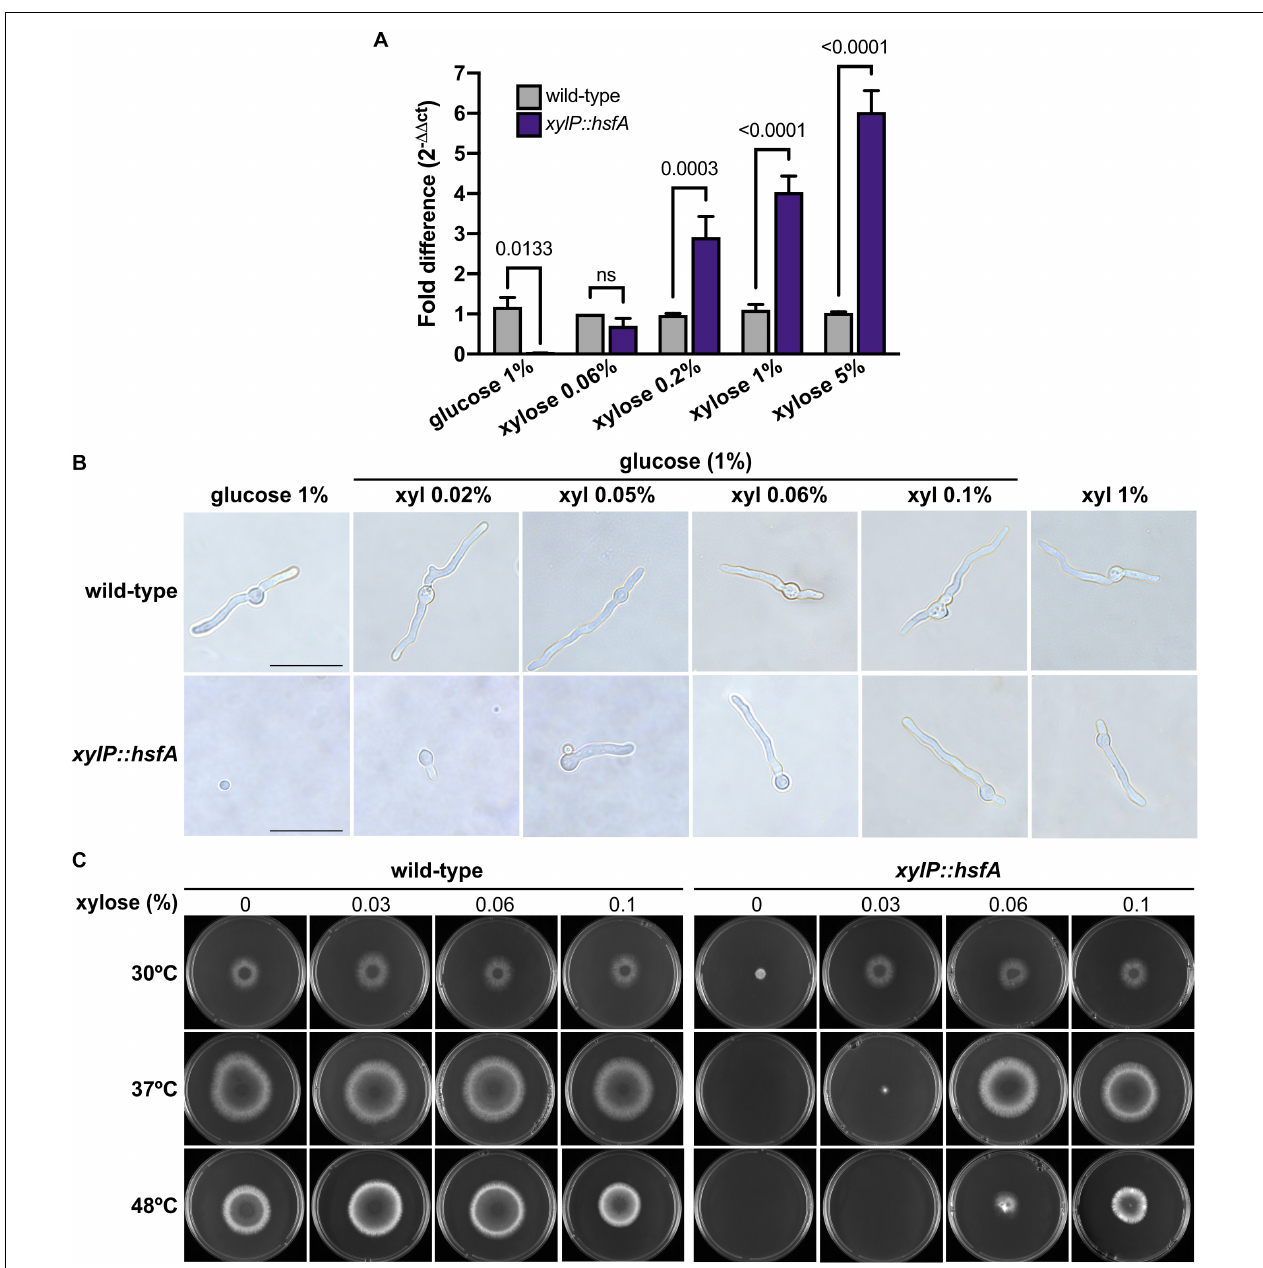
FIGURE 3 | hsfA is essential for vegetative growth and thermotolerance. (A) hsfA expression in the wild-type and conditional lethal xylP::hsfA strain. The strains were grown for 24 h at 37 ◦ C in liquid MM supplemented with xylose 1% and transferred to fresh MM or MM lacking glucose supplemented with different xylose concentrations for 4 h. The fold difference of each condition represents the normalized mRNA abundance in comparison to the wild-type strain. Mean ± SD ( n = 3) are shown. Statistics are indicated by the bars and p values are depicted (ns: non-significant; two-way ANOVA and Sidak’s multiple comparison test). (B) hsfA is required for A. fumigatus germination. The wild-type and xylP::hsfA strains were cultivated for 12 h at 37 ◦ C in glass-bottom dishes containing 2 ml of MM (glucose 1%) supplemented with increasing concentrations of xylose (xyl), or in xylose 1% as the sole carbon source. Magnification 100 × ; bar = 10 µ m. (C) Radial growth of the wild-type and xylP::hsfA strains under repressive (glucose) or inducing conditions (xylose). A total of 1 × 10 4 conidia of wild-type and xylP::hsfA strains were inoculated into the center of solid MM plates supplemented with the indicated concentrations of xylose and incubated at 30 ◦ C, 37 ◦ C, or 48 ◦ C for 72 h.